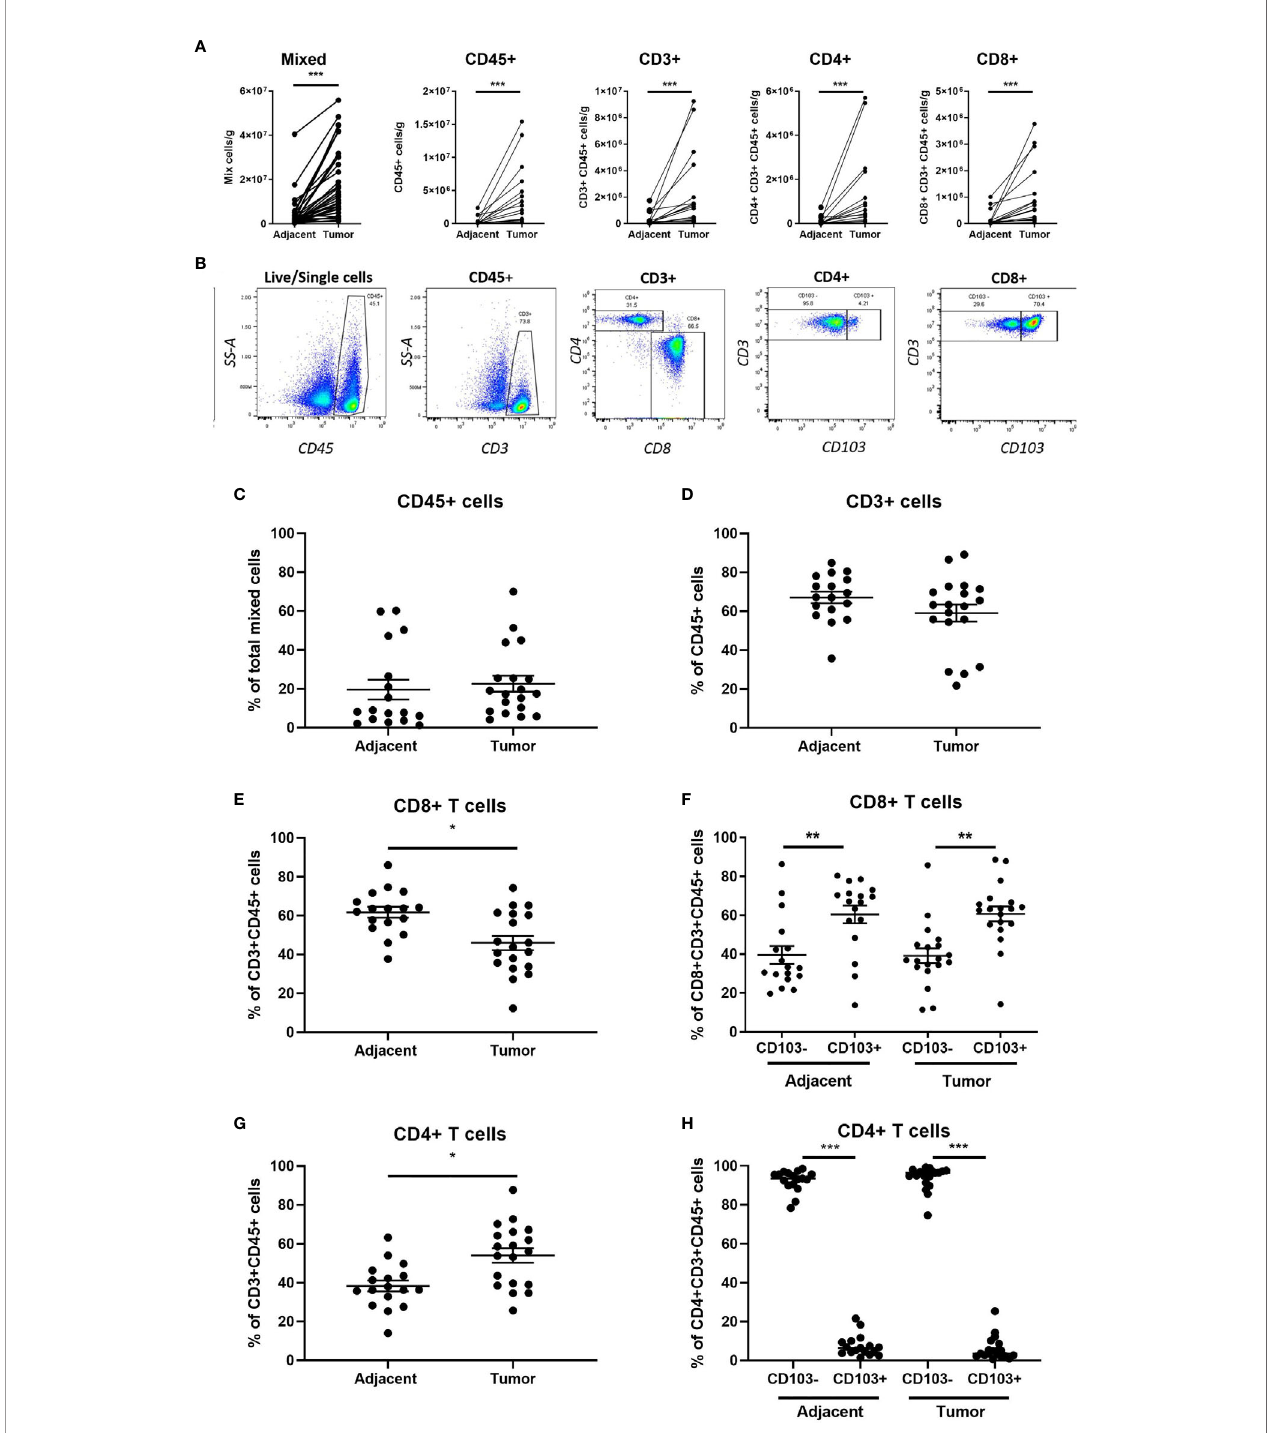
FIGURE 1 | Increased Immune Cell Numbers in Matched Endometrial Carcinomas versus Adjacent Non-Cancerous Tissues. The number of cells per gram of tissue in different subsets (total mixed cells, CD45+, CD45+CD3+, CD3+CD4+, and CD3+CD8+) from matched endometrial carcinomas and adjacent non-cancerous tissue (A) . Representative fl ow cytometry gating panel to determine the presence of CD45+, CD3+, CD4+, CD8+, and CD103+ cells in mixed cell preparations from both adjacent non-cancerous endometrium and endometrial carcinoma tissues (B) . The percentage of total CD45+ (C) , CD3+ (D) , CD8+ (E) , CD4+ (F) T cells, and CD103 +/- CD8+ (G) and CD4+ (H) T cells in matched endometrial carcinoma and adjacent non-cancerous tissue was determined by fl ow cytometry. Each circle represents an individual patient. *p<0.05, **p<0.01, ***p<0.001. Wilcoxon matched-pairs signed rank